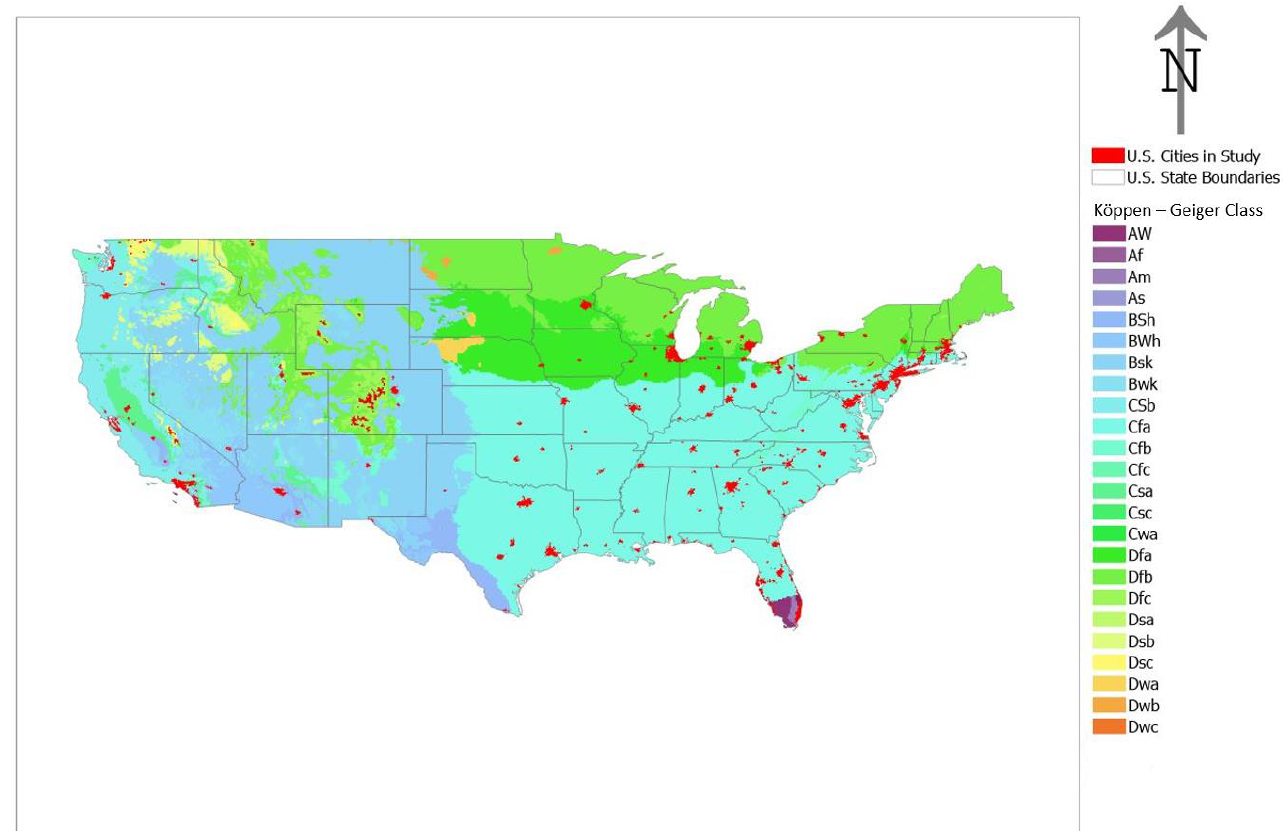
Figure 1. Urban areas in the study (n = 191) and their respective Köppen–Geiger climate classification. All cities and census tracts were assigned to their respective climate zone to account for climatic variations in the